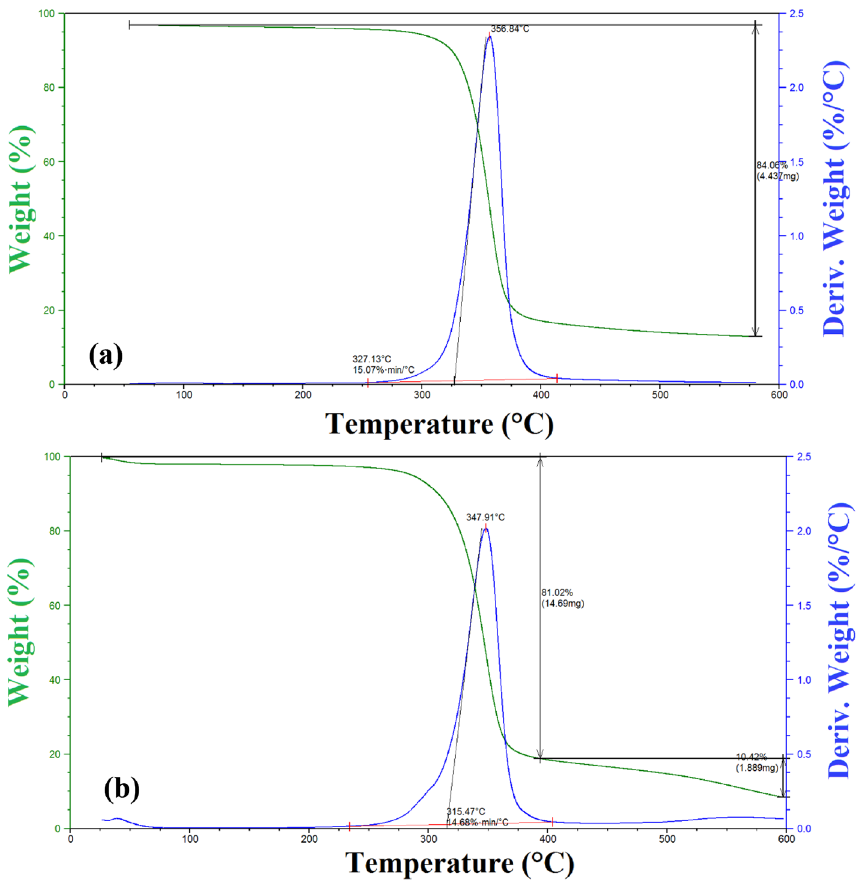
Figure 6. TGA analysis of ( a ) Cellulose di-acetate (Sample 5), ( b ) CA-PEG blend membrane from cellulose di-acetate (Sample 5) and